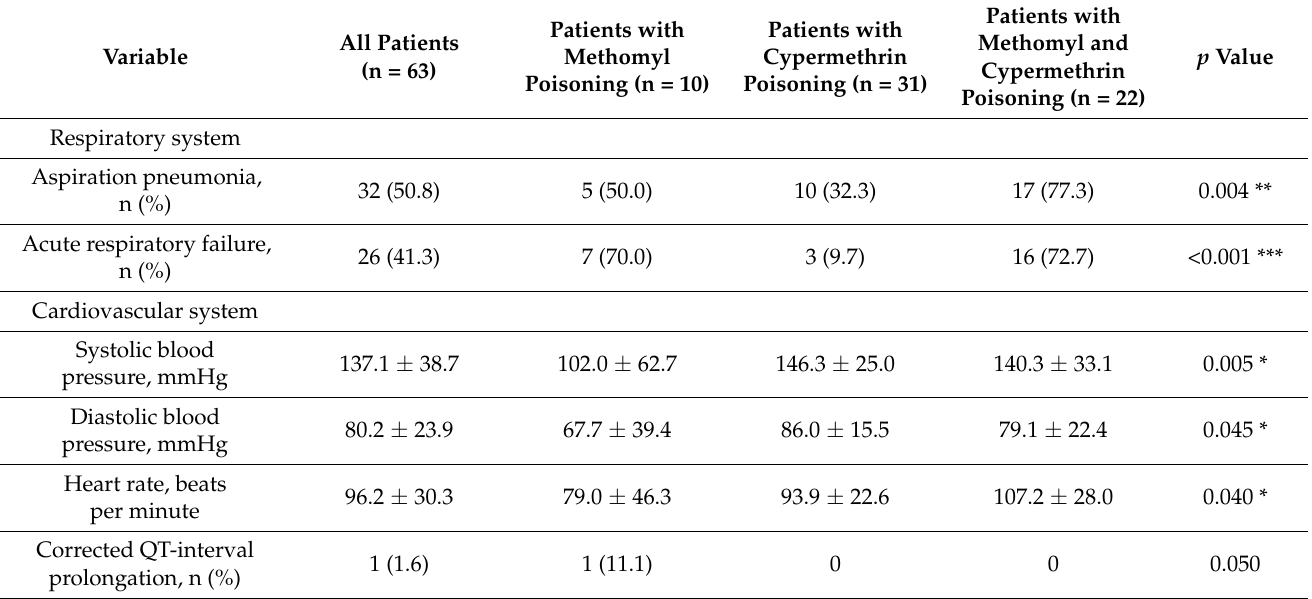
Table 2. Clinical findings of patients with pesticide poisoning, stratified by type of pesticide (n =